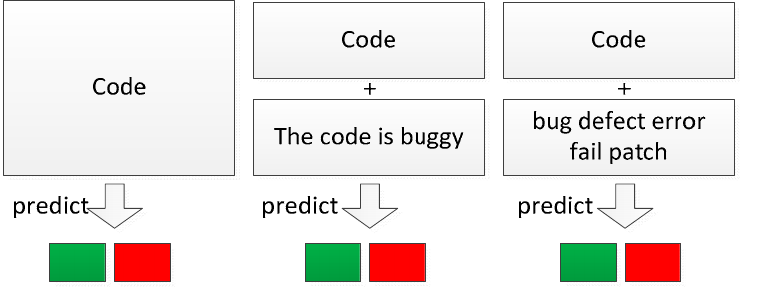
Figure 5. Traditional, sentence-based, and keyword-based prediction patterns. The classification model is omitted for simplicity.